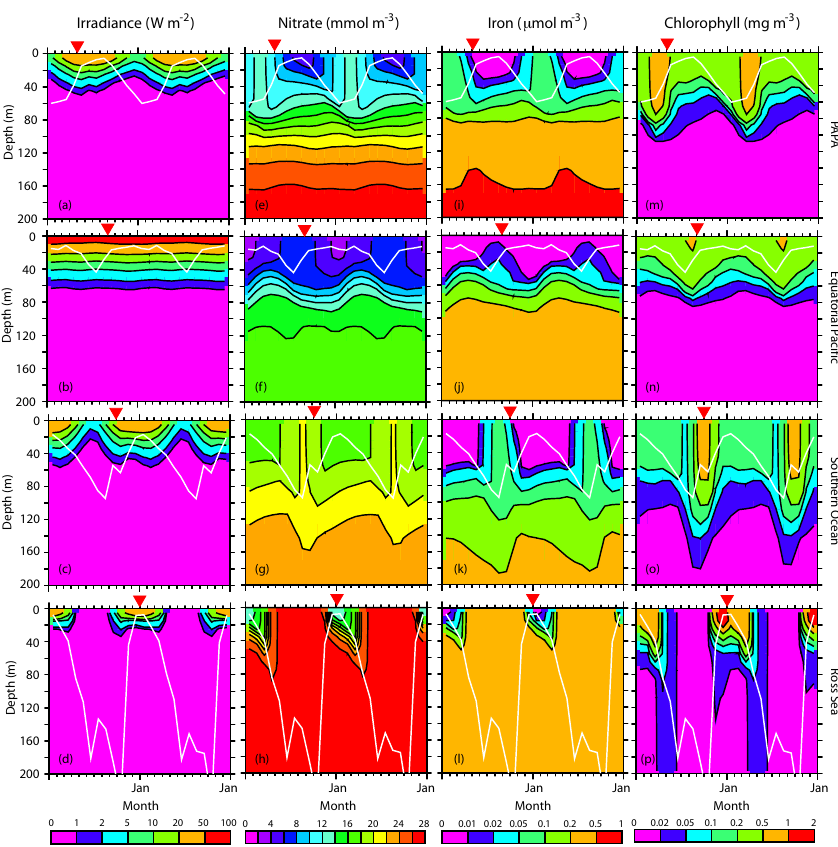
Fig. 3. Results of the control simulation contoured as a function of depth versus time at each of the four iron fertilization sites. The white line is the KPP mixed layer depth defined in the text. The red arrow at the top is the month when iron is added in the 1x, 10x, and 100x fertilization scenarios. Each row is a separate site with PAPA at the top, the Equatorial Pacific and Southern Ocean in the middle two rows, and the Ross Sea at the bottom. The first column shows irradiance in Wm − 2 , (a–d) ; the second column shows nitrate concentration inmmolm − 3 , (e–h) ; the third column shows iron concentration in µ molm − 3 , (i–l) ; and the final column shows chlorophyll concentration in mgm − 3 (m–p) . These are all for two years at the start of the control